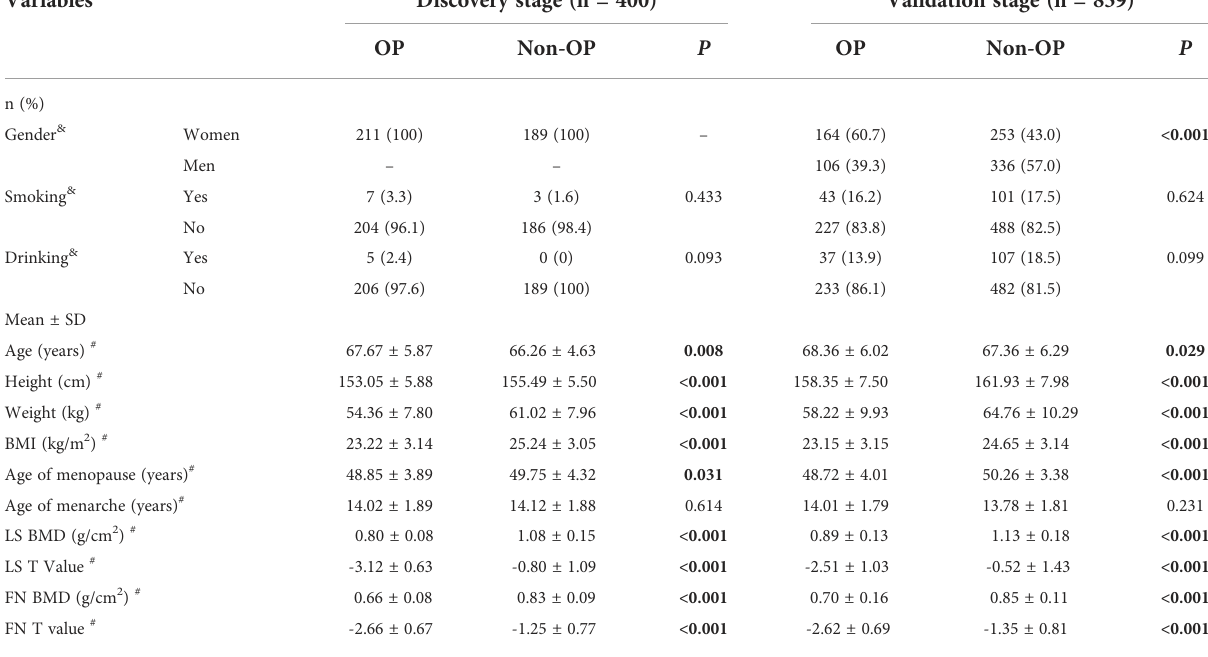
TABLE 1 General characteristics of involved